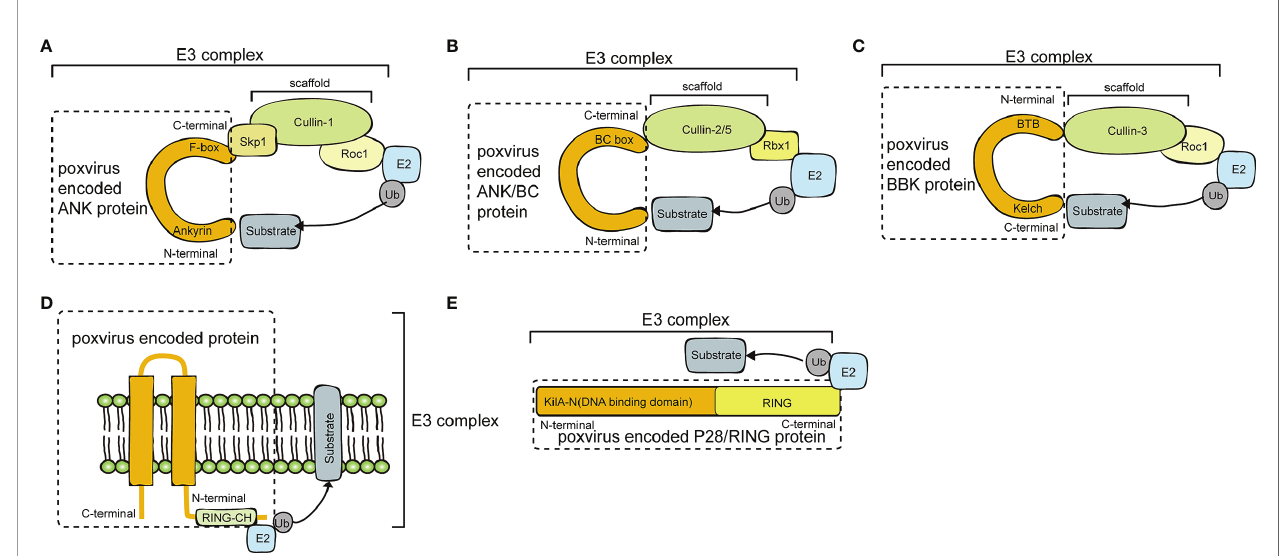
FIGURE 2 | A diagram of poxvirus E3 ubiquitin ligases and adaptor proteins. (A) Schematic diagram of Cullin-1 E3 Ub ligases and poxvirus-encoded pox protein repeats of ankyrin-C-terminal domain (PRANC) protein. (B) Schematic diagram of Cullin-2/Cullin-5 E3 Ub ligases and poxvirus-encoded ankyrin repeat (ANK)/Elongin B/Elongin C (BC) protein. (C) Schematic diagram of Cullin-3 E3 Ub ligases and poxvirus-encoded BTB/Kelch (BBK) protein. (D) Schematic diagram of P28/RING protein. (E) Schematic diagram of membrane-associated RING-CH (MARCH)